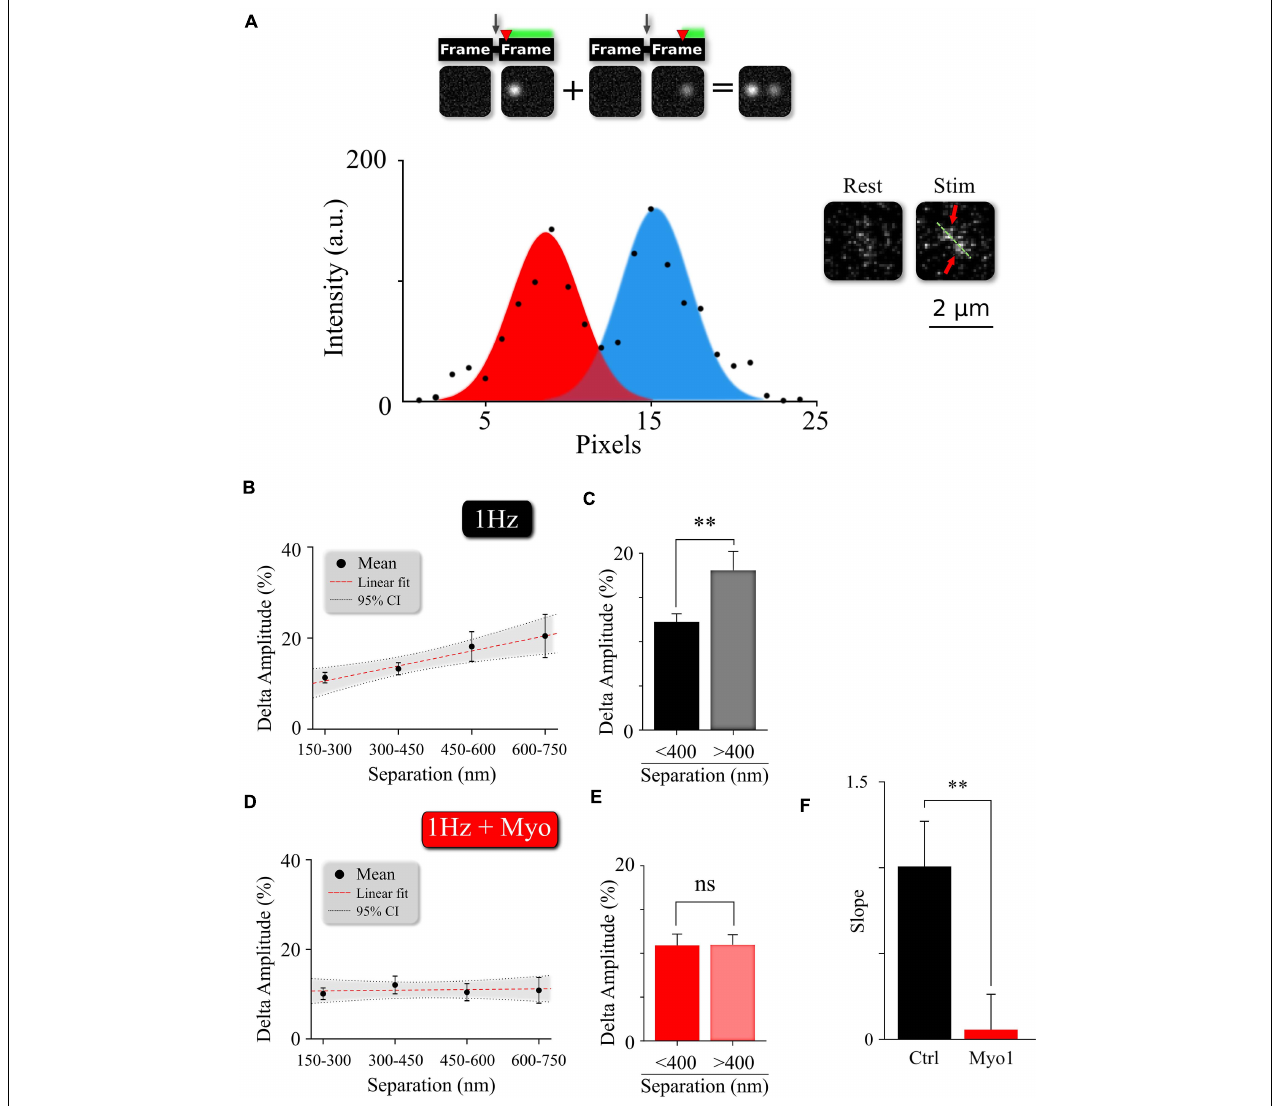
FIGURE 4 | Myosin V regulates temporal separation within MVR events. (A) Sample image and intensity profile of an MVR event with noticeable difference in intra-event amplitude. Top, Insert: A cartoon diagram shows the relationship between time delay (red arrow) of the second fusion after an action potential and the resulting amplitude difference within an MVR event pair recorded together in the same frame. (B,C) Amplitude difference of the two events comprising MVR as a function of intra-event distance. Linear fit (B) and t -test of pooled data (C) are shown. (D,E) Effect of myosin V inhibition with Myo-1 on the amplitude difference of the two events comprising MVR as a function of intra-event distance. Linear fit (D) and t -test of pooled data (E) are shown. (F) Quantification of the effects of Myo-1 in panel (D) assessed by comparing the slopes of the correlations in (B,D) . Two-sample t -test (C,E) . One-way analysis of covariance (F) . ∗∗ p < 0.01; ns, not